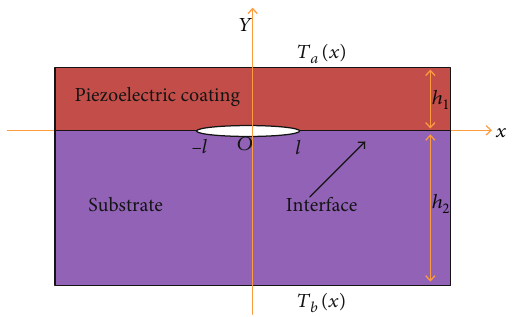
Figure 1: Mechanical structure of fi ne-grained piezoelectric coating/substrate with interface